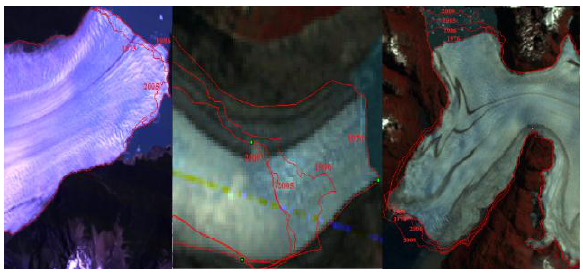
Figure 3. Linhas de variação na posição da língua das Geleiras Moreno, O’Higgins e Bruggen. Geradas a partir de imagens Landsat 7 ETM+ para os de 1976-1979-1986-